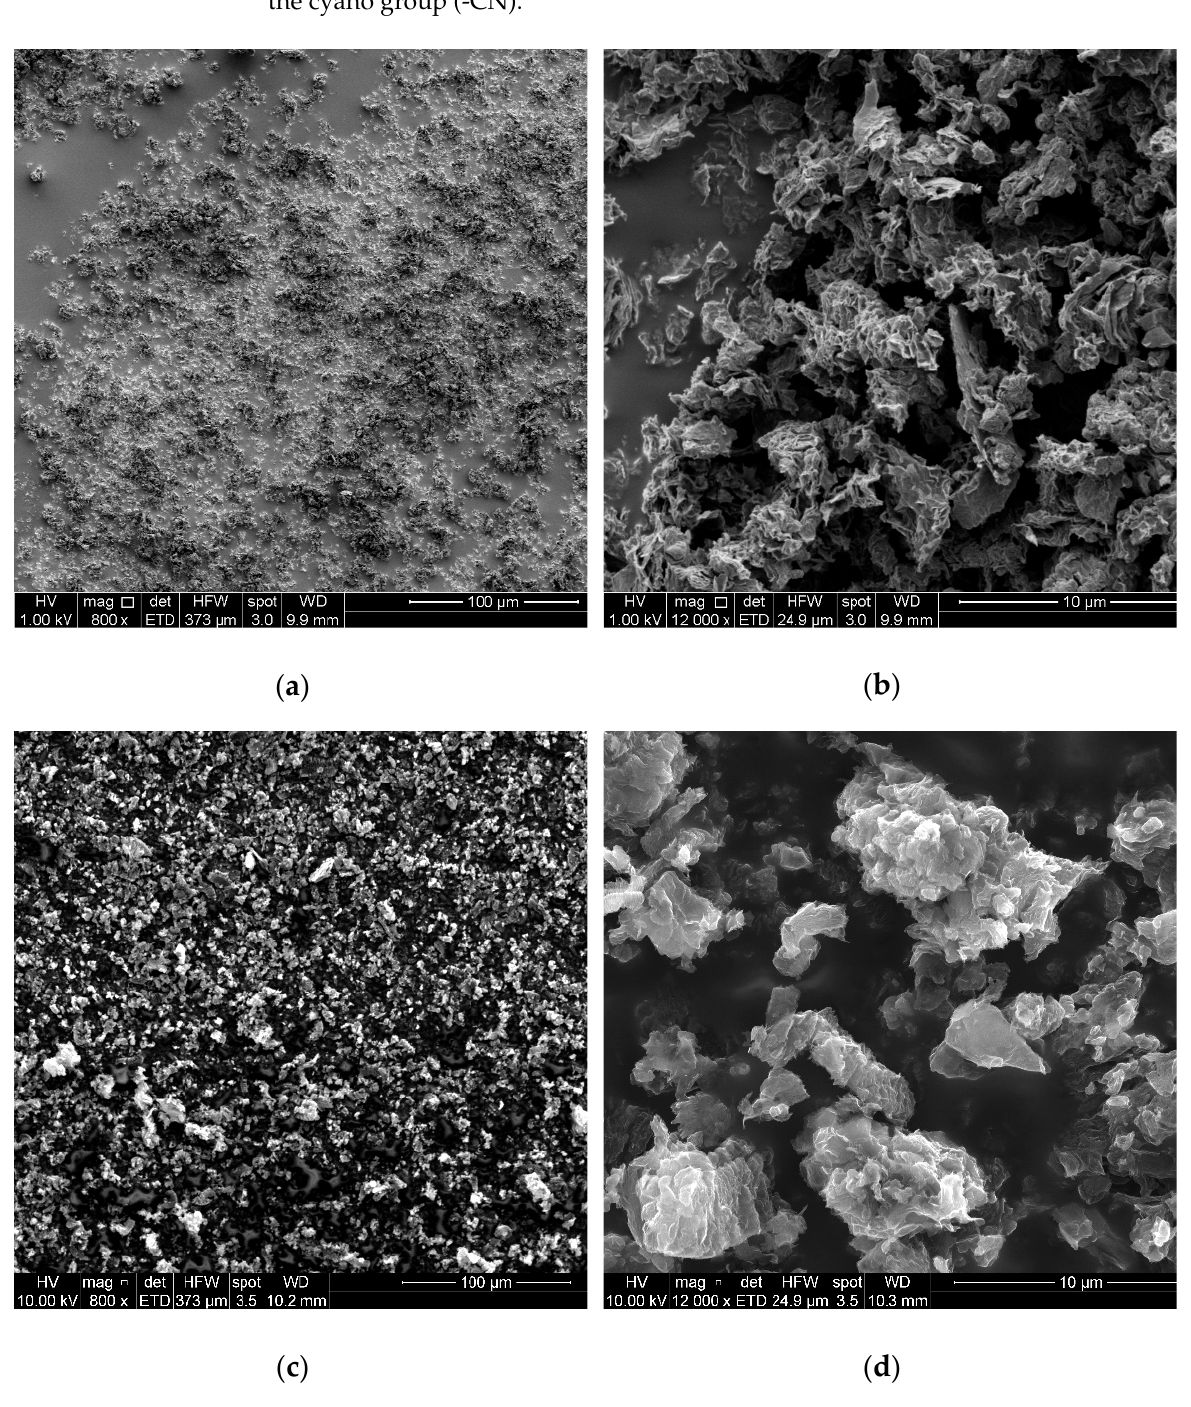
Figure 5. SEM images of ( a ) rGO 800 × , ( b ) rGO 12,000 × , ( c ) GO-g-PMMI/BTN 800 × and Figure 5 . SEM images of ( a ) rGO 800×, ( b ) rGO 12,000×, ( c ) GO-g-PMMI/BTN 800× and ( d ) GO-g- ( d ) GO-g-PMMI/BTN 12,000 × PMMI/BTN 12,000×.